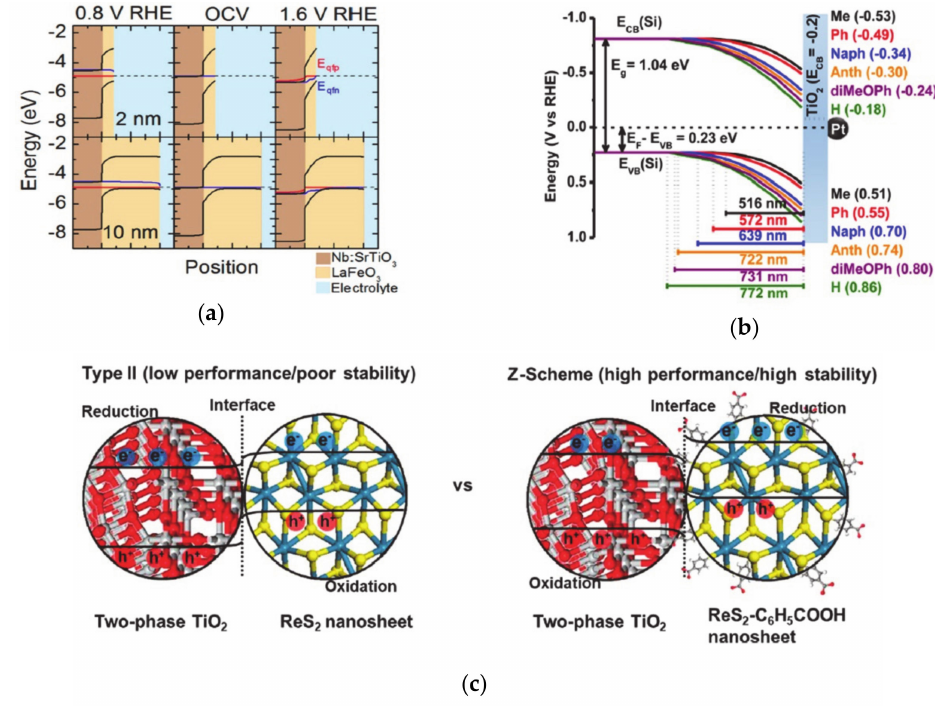
Figure 4. ( a ) The band bending introduced by perovskite oxide on the surface, which is reproduced from Ref. [90] with permission from the Royal Society of Chemistry. The thickness of perovskite oxide changes the Fermi level at the surface and, as a result, changes the open-circuit potentials. ( b ) The band reproduced from Ref. [100] with permission from the Royal Society of Chemistry ( c ) The